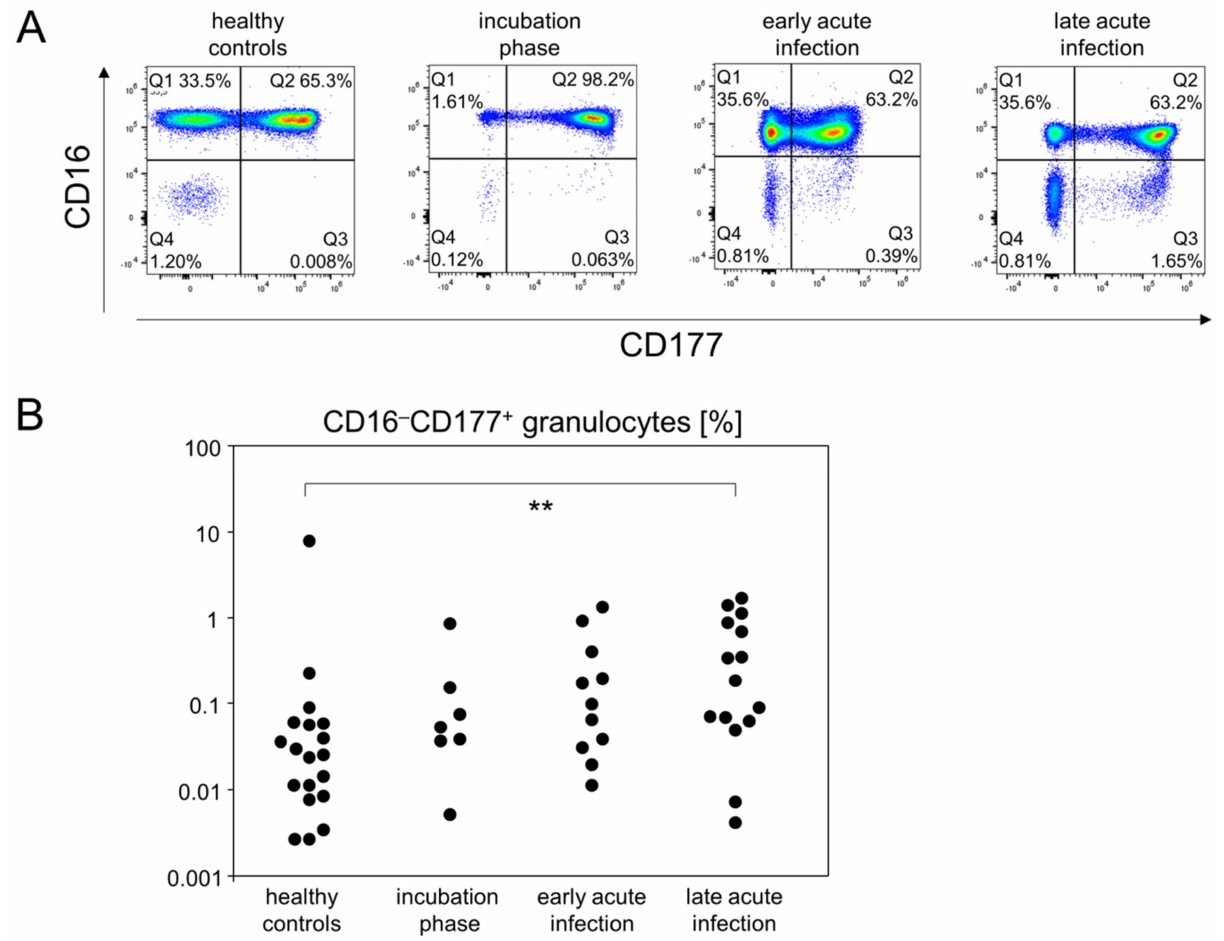
Figure 4. The portion of CD16 − CD177 + granulocytes gradually increased until the late acute infection phase. ( A ) Representative pseudocolor plots of CD16 and CD177 expression data of SSC hi